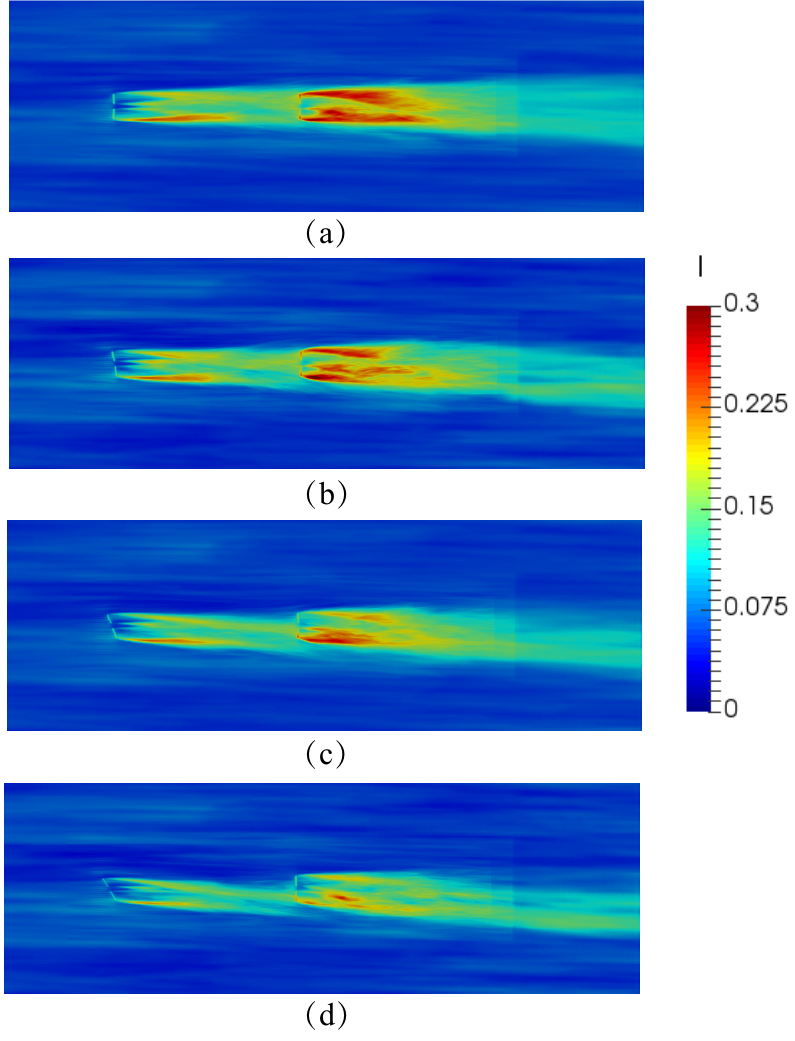
Figure 18. Contours of instantaneous turbulence intensity in the horizontal plane at hub